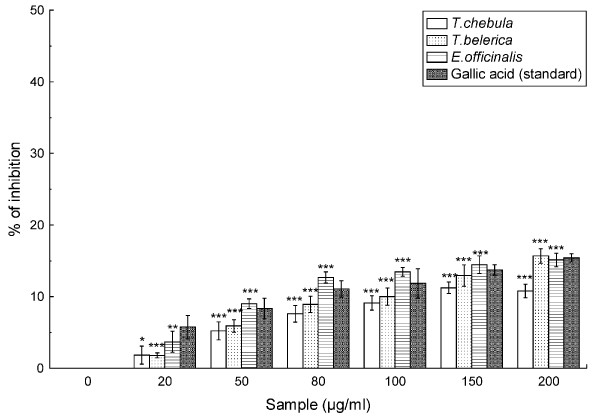
Peroxynitrite anion scavenging assay. The peroxynitrite anion scavenging activity of T. chebula, T. belerica and E. officinalis plant extracts and standard gallic acid. Each value represents mean ± S.D. (n = 6). *p < 0.05, **p < 0.01 and ***p < 0.001 vs 0 μg/ml.